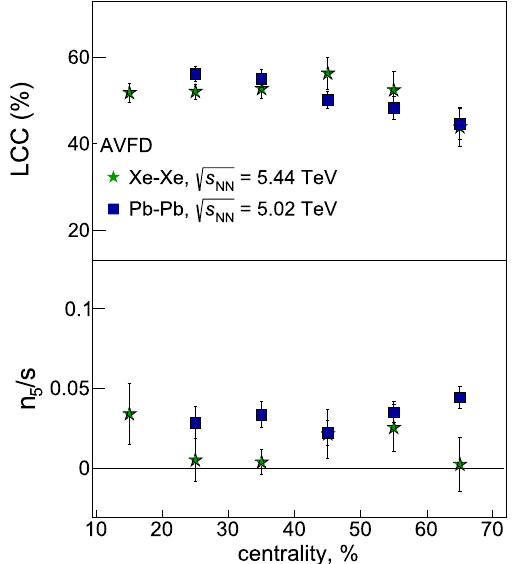
Fig. 10 The centrality dependence of the LCC percentage (upper panel) and the axial current density n 5 / s that allows to describe simul- taneously the experimental measurements of (cid:9)δ 1 and (cid:9)γ 1 , 1 [28,41,42] in all collision systems and energy studied in this article